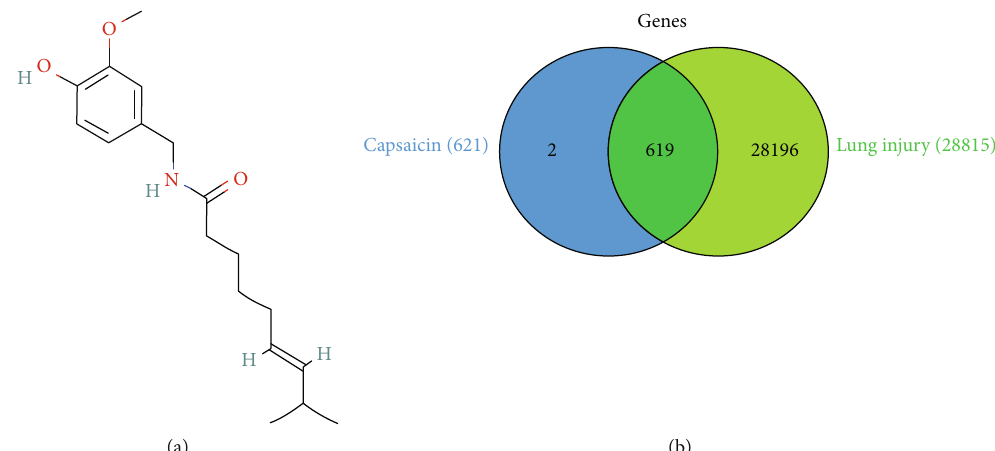
Figure 1: Potential genes of Cap against acute lung injury. Chemical structure of Cap (a). Venn map between target genes from Cap and lung injury